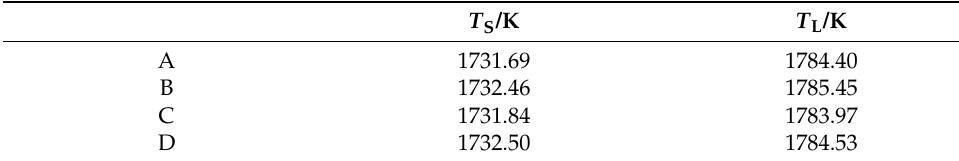
Table 3. Solid and liquidus temperature of